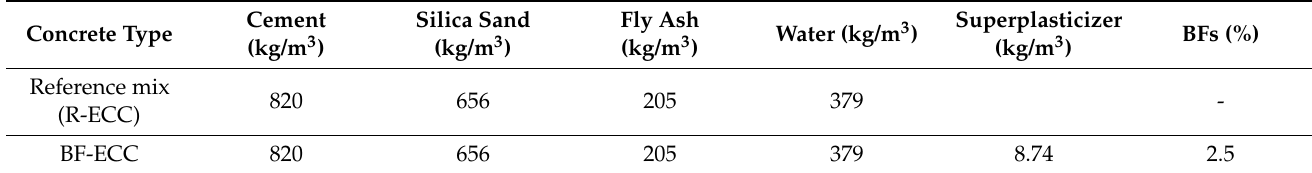
Table 3. The mix design and the proportions of the constituent materials in the